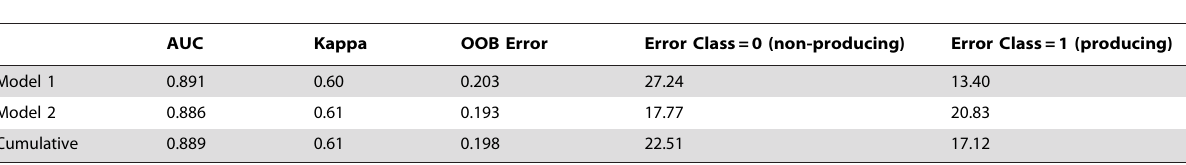
Table 1. Accuracy statistics for the oil and gas prediction